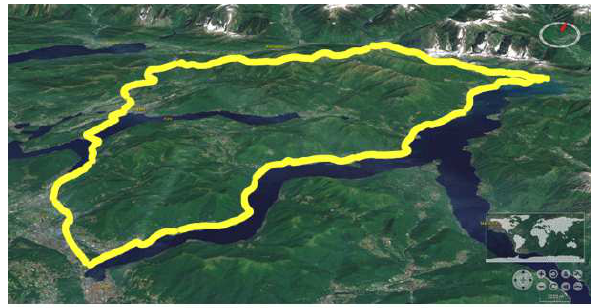
Figure 4. The area covered by the Via Regina project